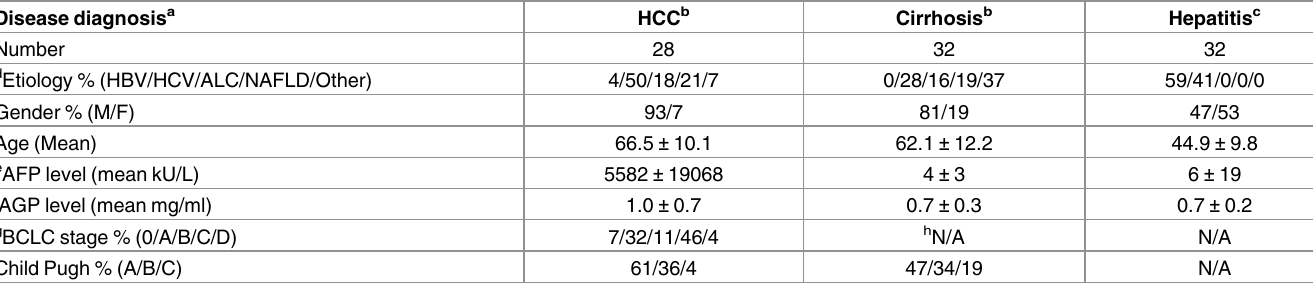
a Samples were provided coded from Karolinska University Hospital and the Infectious Disease Clinic at Kalmar County Hospital b HCC diagnosis was determined according to the guidelines of EASL and AASLD for a cirrhotic liver. For non-cirrhotic livers HCC diagnosis was determined by liver biopsy. Cirrhosis was determined with Fibroscan ( > Z14kPa) and ultrasound. c Patients classified as HBV or HCV were defined as those with HBsAg positivity or HCV-RNA positivity but no evidence of cirrhosis d autoimmune hepatitis, cryptogenic liver disease, hemochromatosis, primary biliary cirrhosis and healthy livers e AFP was determined using standard methods (COBAS, Roche Diagnostics) f AGP concentrations were determined using standard methods (ProSpec, Siemens) g HCC staging was determined using the Barcelona-Clinic Liver Cancer (BCLC) classification